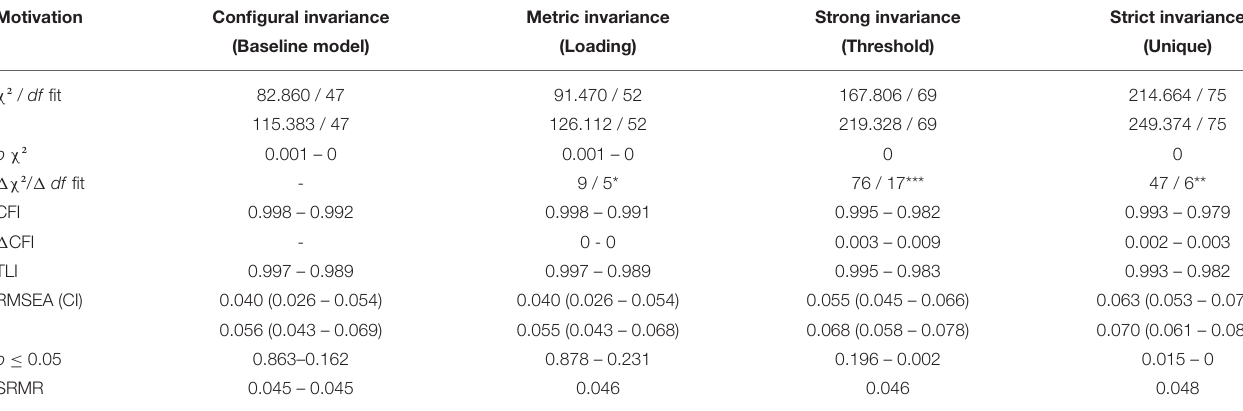
TABLE 3 | Analysis of the longitudinal factorial invariance for the motivation variable.